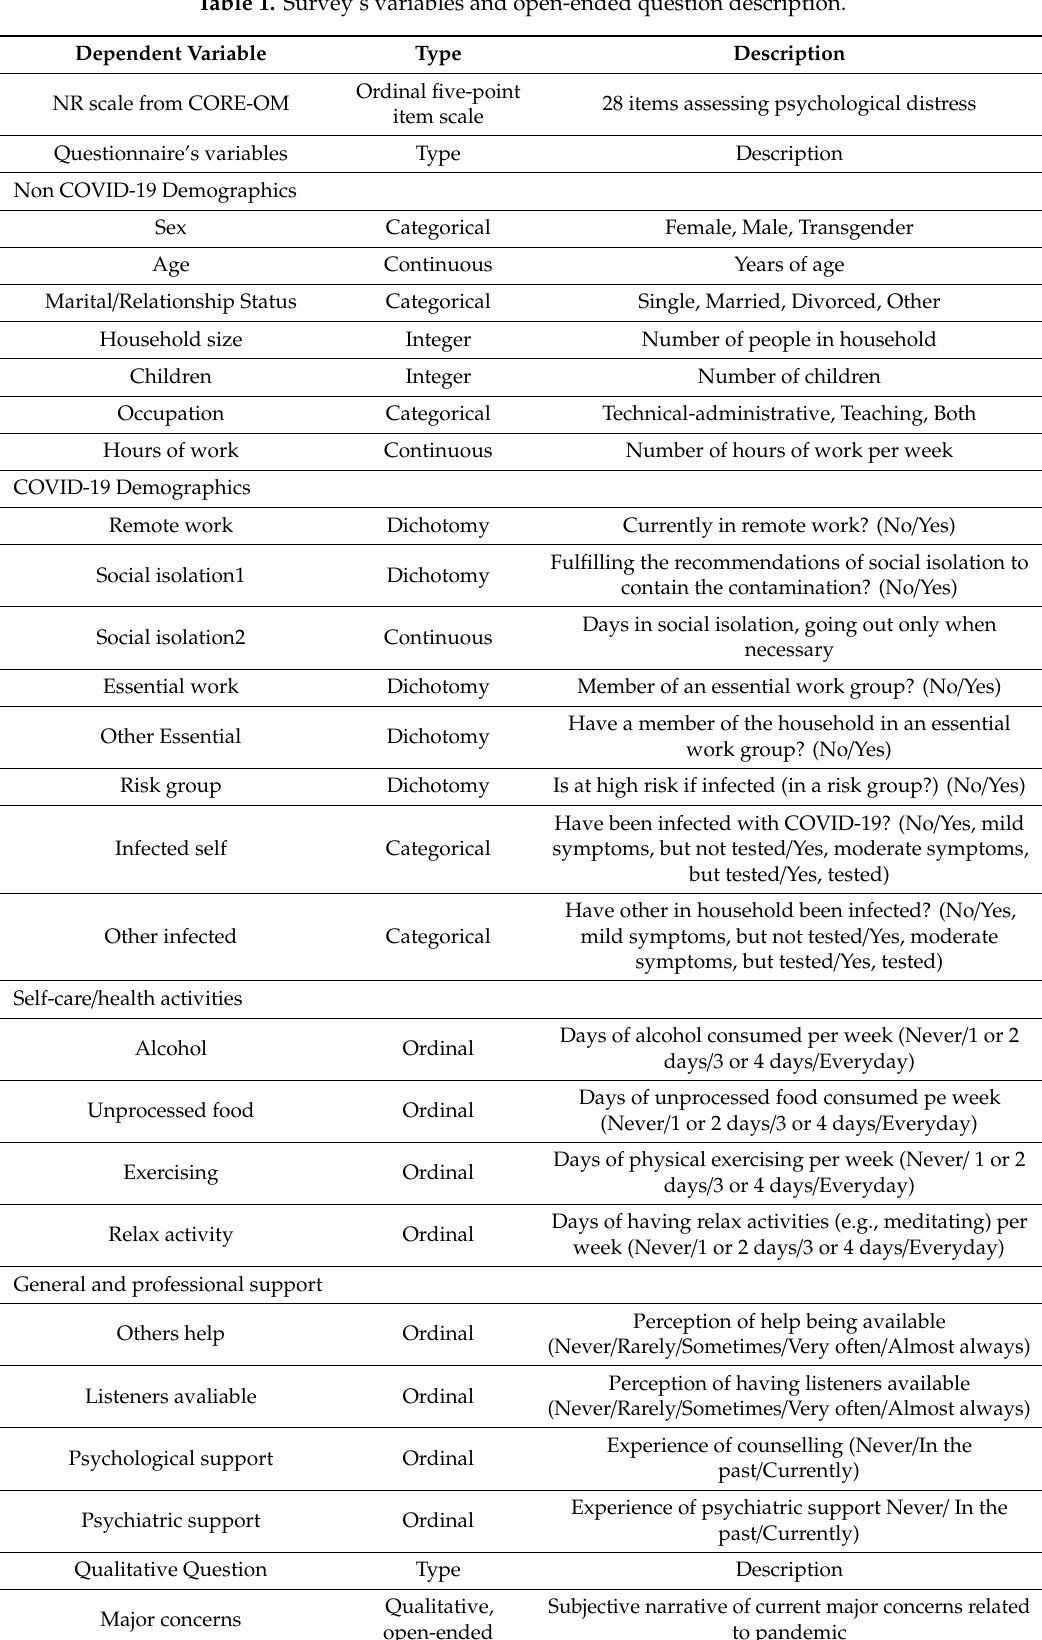
Table 1. Survey’s variables and open-ended question